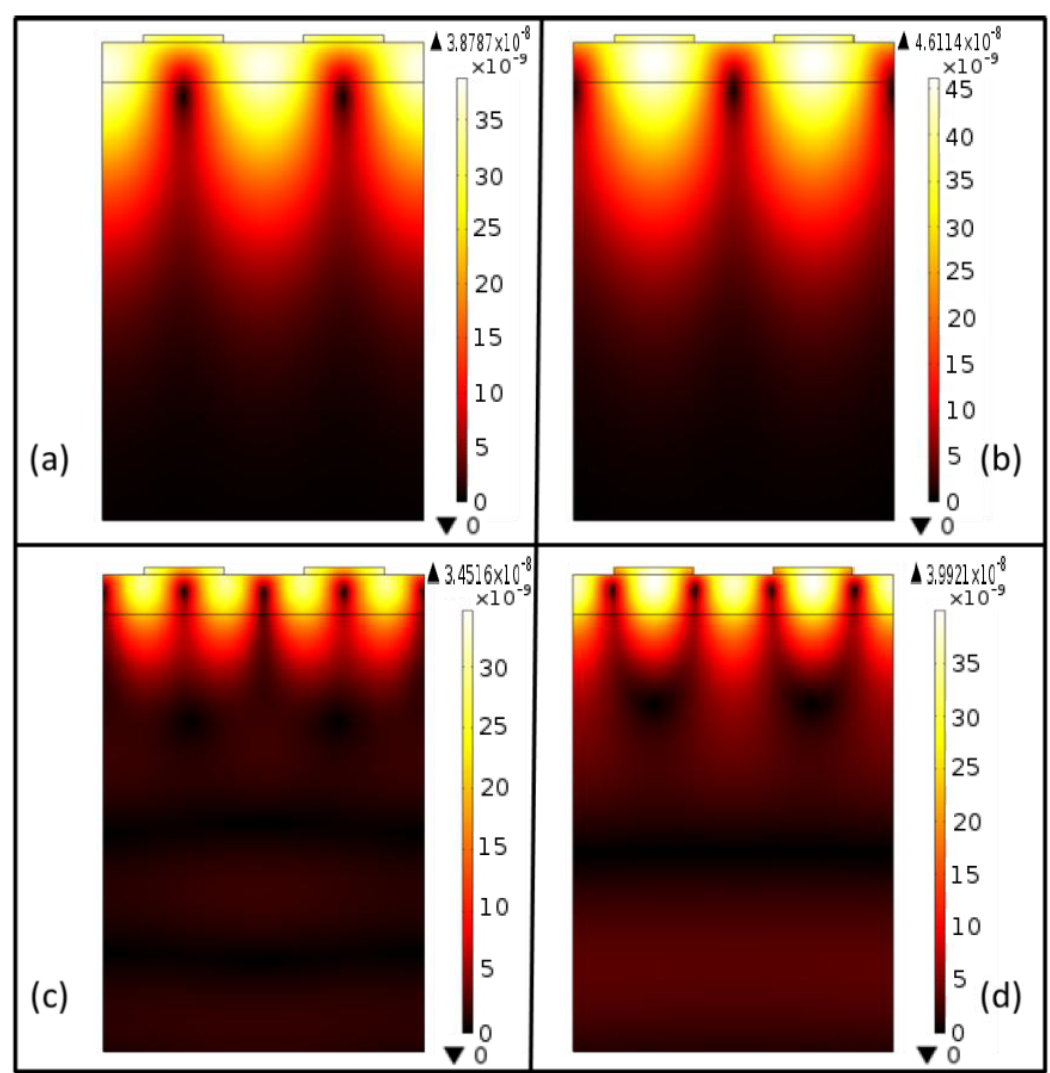
Figure 2. Total displacement profile showing acoustic wave mode shapes. ( a ) Rayleigh wave mode resonance ( b ) Rayleigh wave mode anti-resonance ( c ) Sezawa wave mode resonance ( d ) Sezawa wave mode